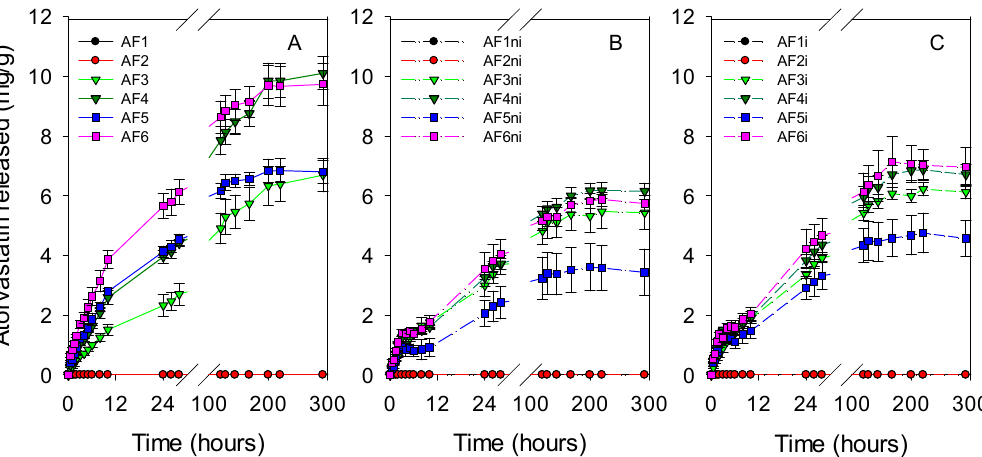
Figure 5. Atorvastatin release profiles from drug-loaded discs (( A ) first set of hydrogels; ( B ) nonimprinted hydrogels and ( C ) imprinted hydrogels) in SLF at 37 °C under magnetic stirring (150 rpm). Codes as in Table 1 ( n = 4; mean values and standard deviations).